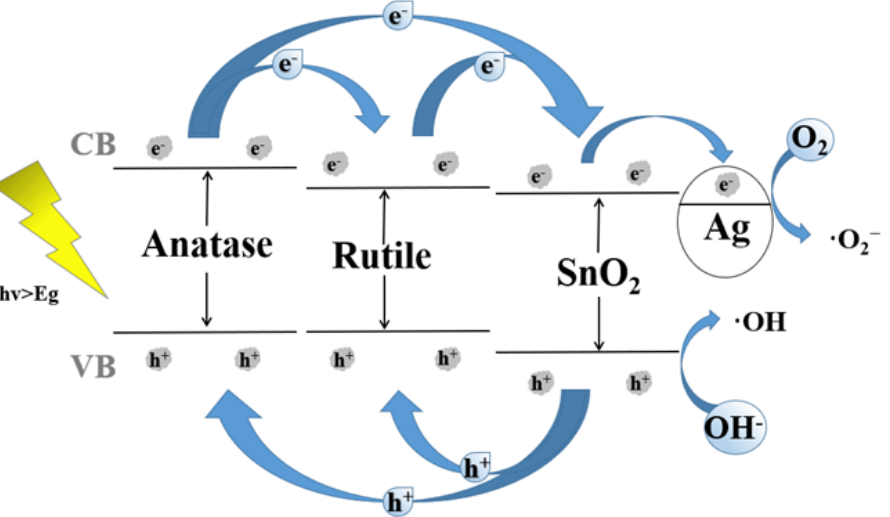
Figure 10. The energy band structure and the diagram of photogenerated charges transfer of Ag@SnO 2 /TiO 2 .